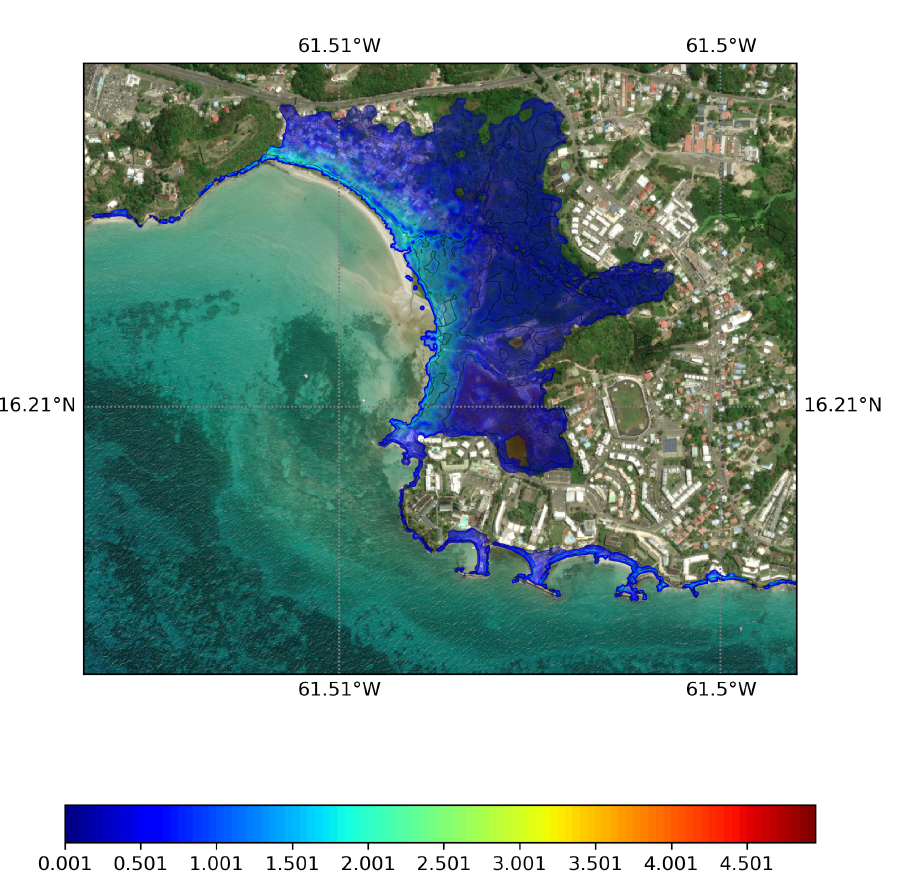
Figure 9. Maximum water depth in Grand Baie, Grande-Terre for the 40 km 3 scenario in the future configurations.